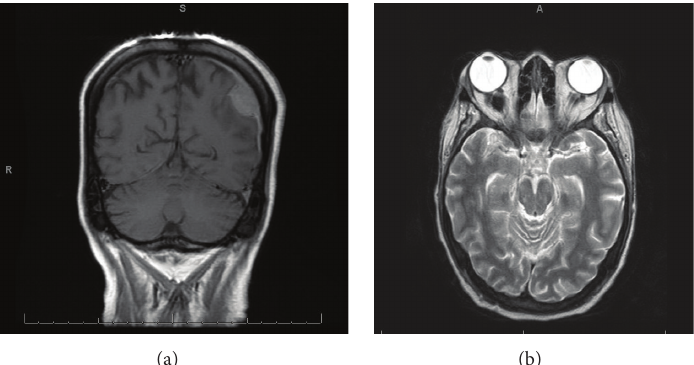
Figure 1: MRI brain coronal section (a) and transverse section (b) showing dural-based mass in the left temporoparietal region as well as mass lesions within the orbits.